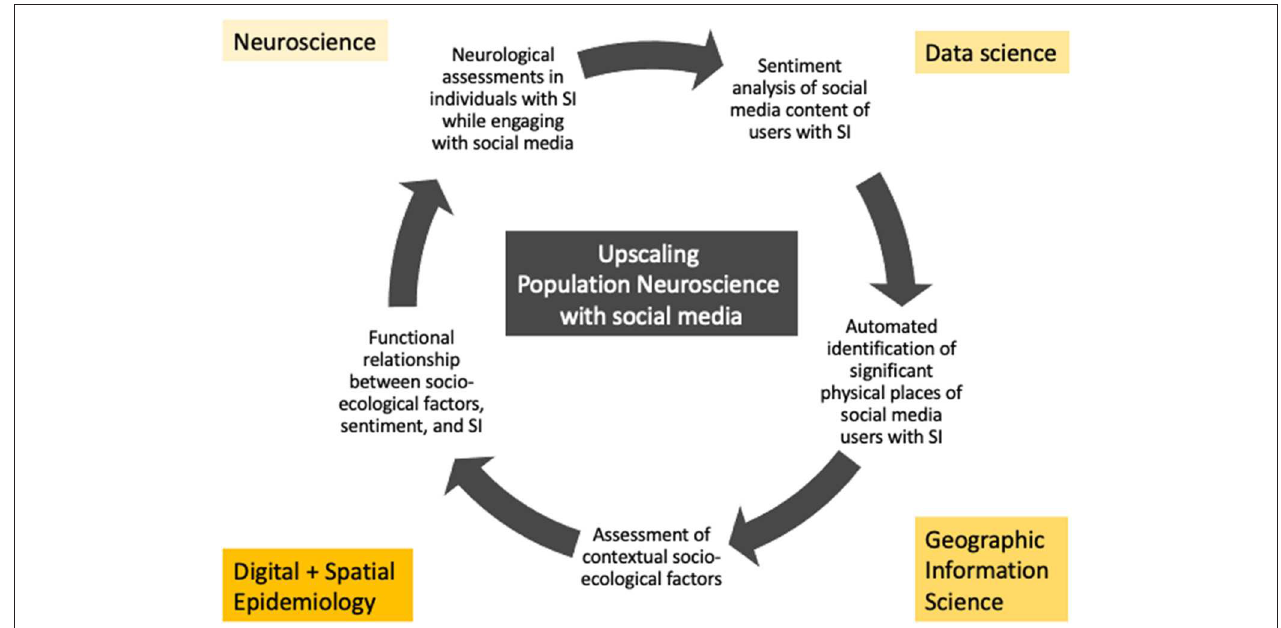
FIGURE 1 | Upscaling population neuroscience approaches with social media: a generic work flow example.